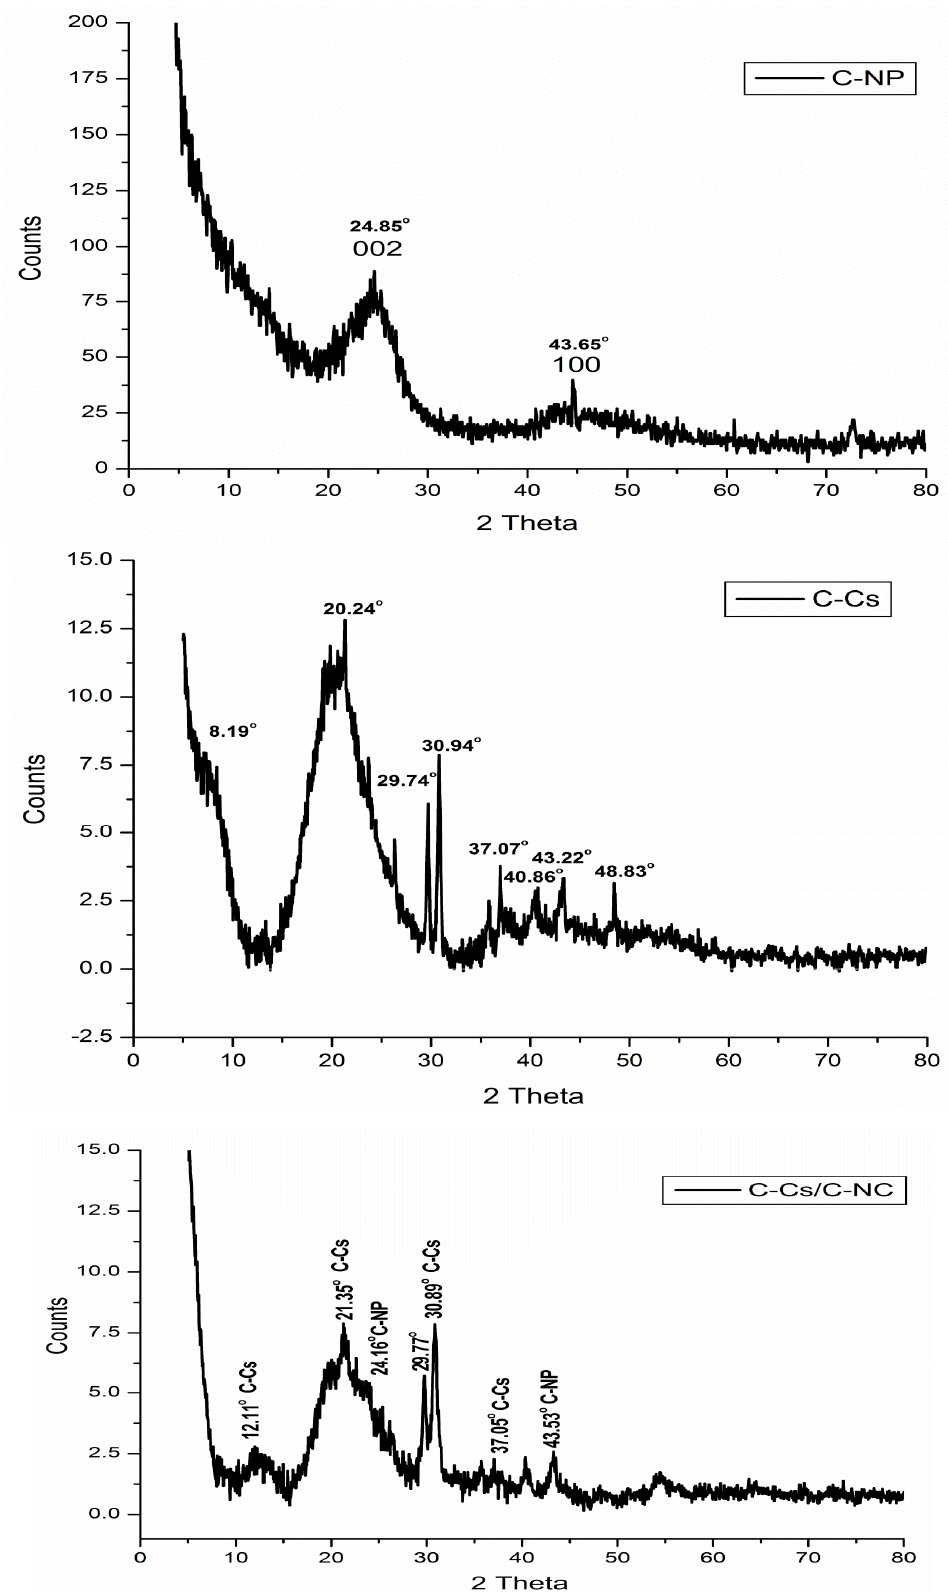
Figure 3. XRD patterns of C-NPs, C-Cs, and C-Cs/C-NC. FT-IR spectra of C-Cs, C-NPs, as well as the synthesized C-Cs/C-NC were illustrated